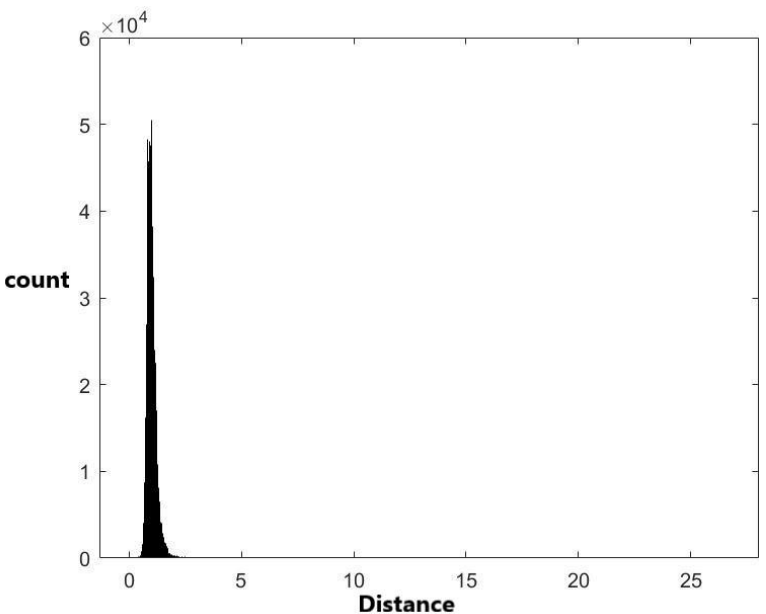
Figure 2. The histogram of 1,836,486 data generated from the fitted empirical distribution.